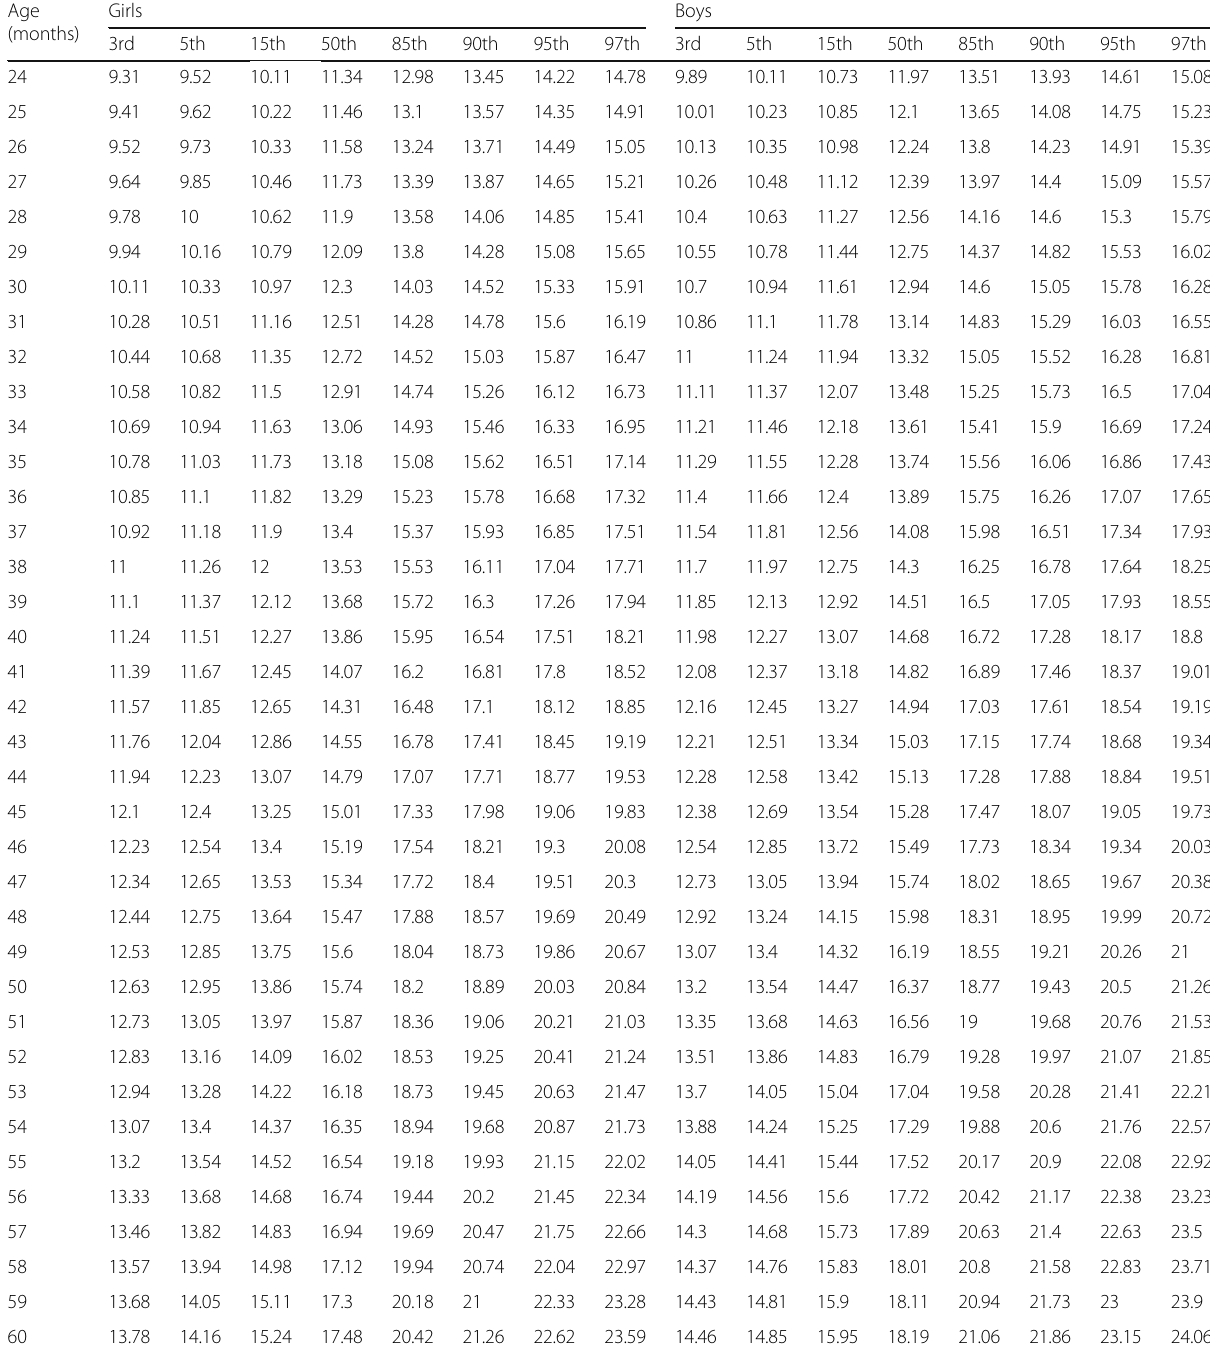
Table 3 Percentiles of weight (kg)-for-age for girls and boys, age in months Age